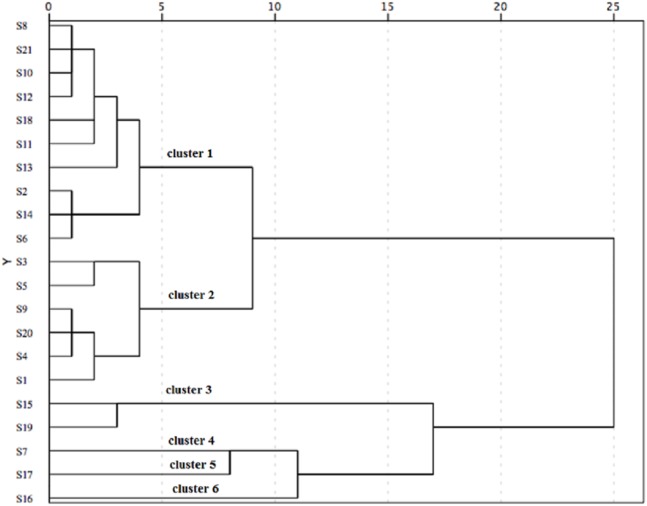
The hierarchical cluster analysis for the antioxidant activity of C. paliurus leaves from 21 populations based on the IC50 of DPPH and ABTS and EC50 of reducing power.